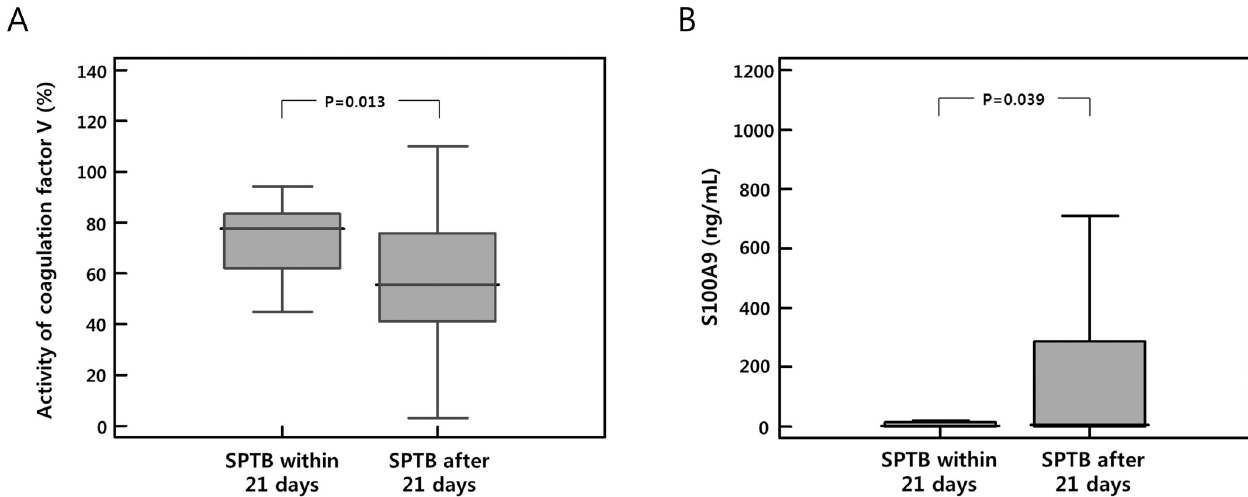
Fig 3. Median activity of coagulation factor Ⅴ and median S100A9 levels with 25 th and 75 th quartile ranges (boxes) and extreme values of each protein in the plasma collected from women who delivered spontaneously within 21 days of sampling (n = 20) and those who delivered after 21 days (n = 84).